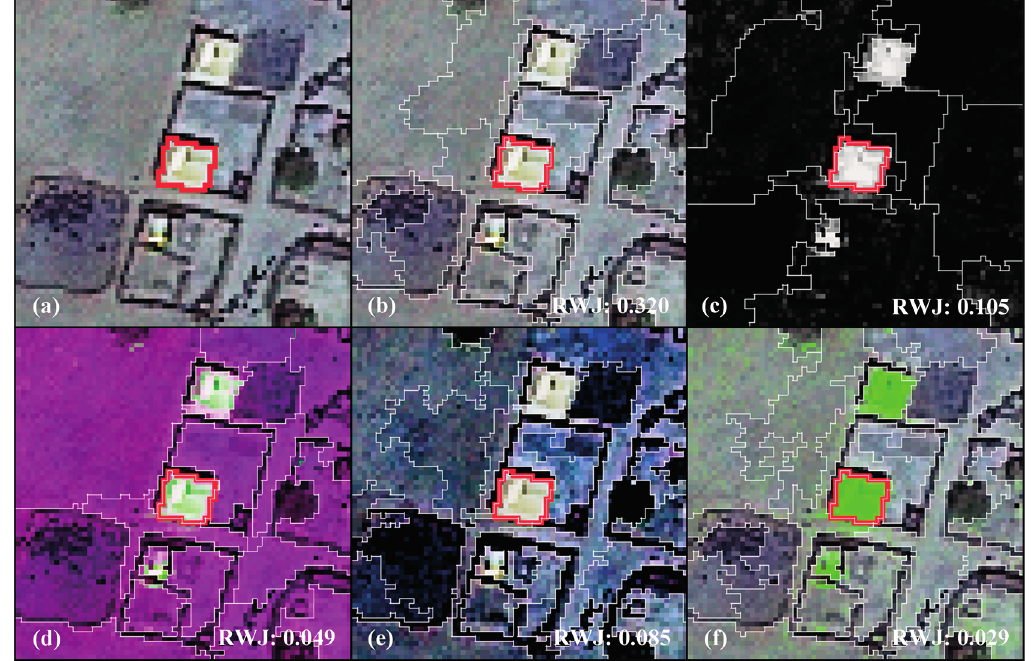
Figure 10. Nemenyi post hoc test performed after a Friedman test, ranking the different methods over all metric and problem instances. Horizontal lines indicate the Critical Differences